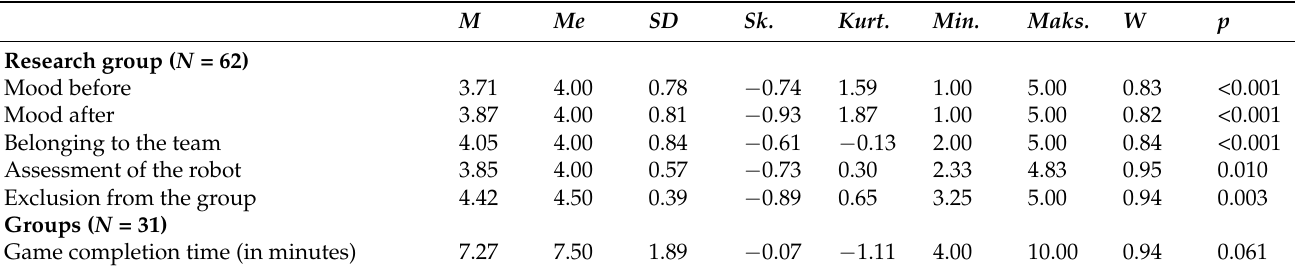
Table 1. Basic descriptive statistics and the result of Shapiro–Wilk test. M